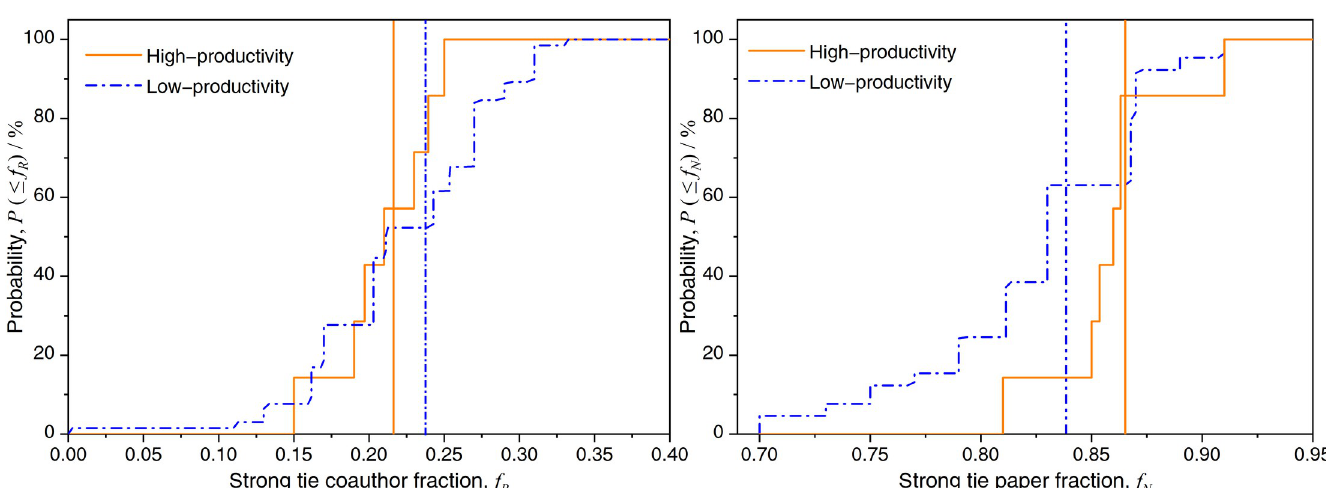
Fig 5. Frequency of strong ties: Vertical lines indicate the distribution mean. (a) Cumulative distribution of the fraction f Cumulative distribution of the fraction f N , i of publications that include at least one strong